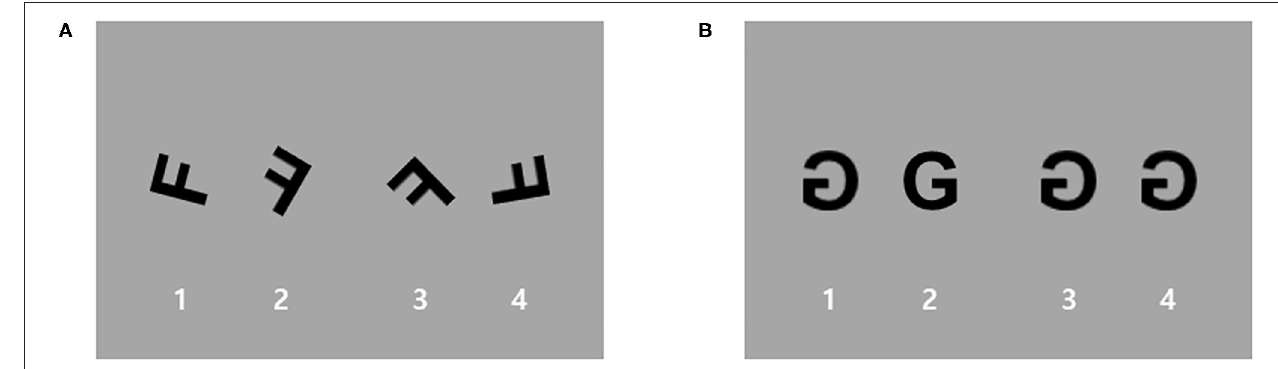
FIGURE 1 | An example of stimuli used for the mental rotation (MR) task. Participants performed a block-designed MR task with two conditions: (A) an MR condition and (B) a zero rotation (ZR) condition as a control condition. For the MR condition, stimuli were rotated by four different angles (40, 80, 120, and 160 degrees), and these rotated characters were mirrored. For the ZR condition, only the characters generated by mirroring the image along the horizontal plane of the picture without any rotation (0 degrees) were used.